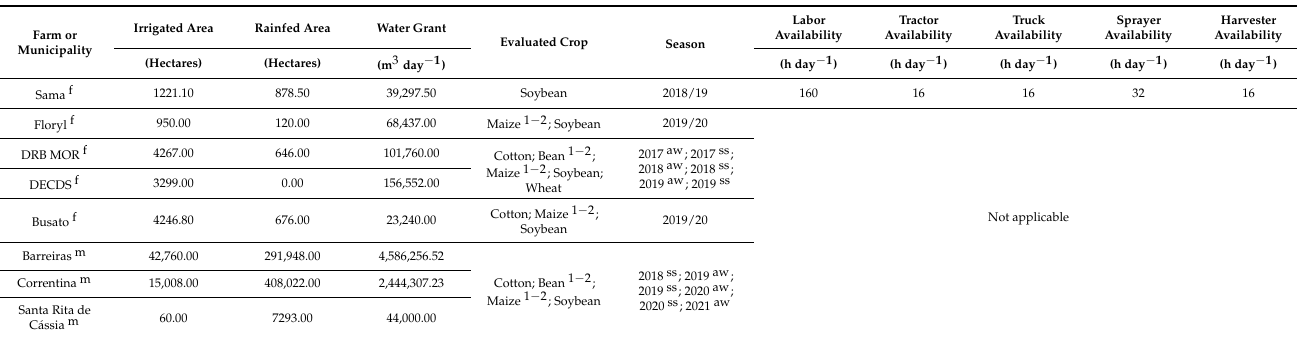
Table 1. Description of resource availability, crops, and crop season adopted in LPM’s analysis in municipalities and farms.